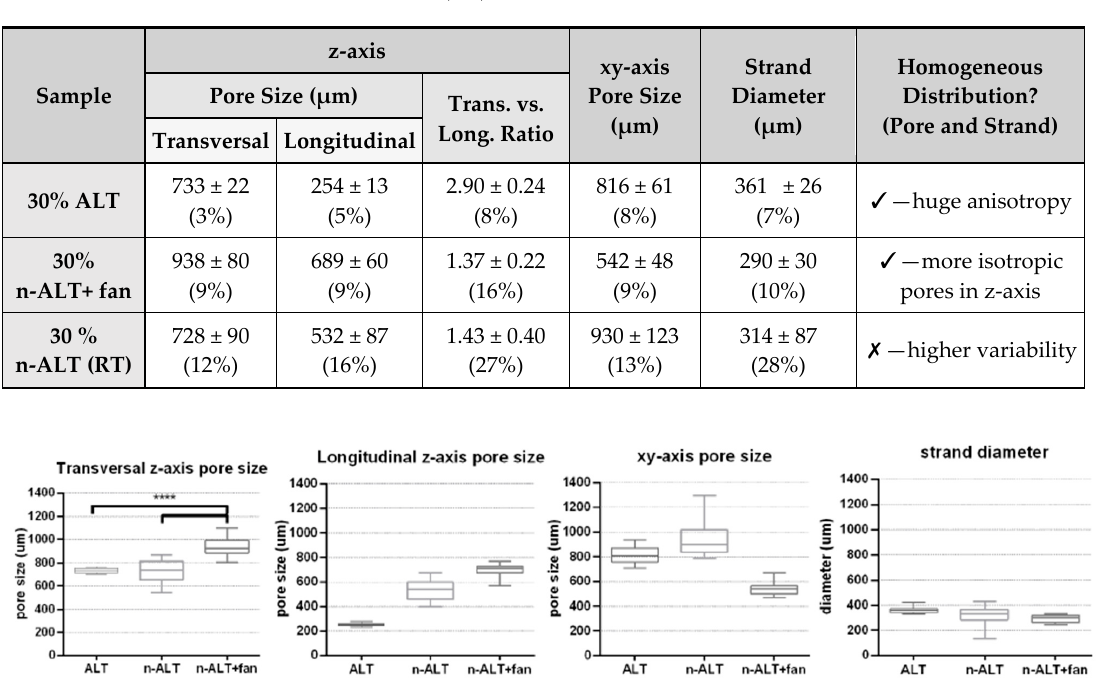
Figure 4. Micrograph of macro and micro pores and microfibres created randomly for a slow cooling down (not forced air flow) of the PCL (30% n-ALT). Scale bars: 100 µm. Table 3. Pore and strand size distribution (values represented by its means ± SD, standard deviation) for 30% ALT, n-ALT (room temperature cooling down, RT) and n-ALT forced cool down (+fan). In addition, the coefficient of variation of the results (x%) was included for each measurement.